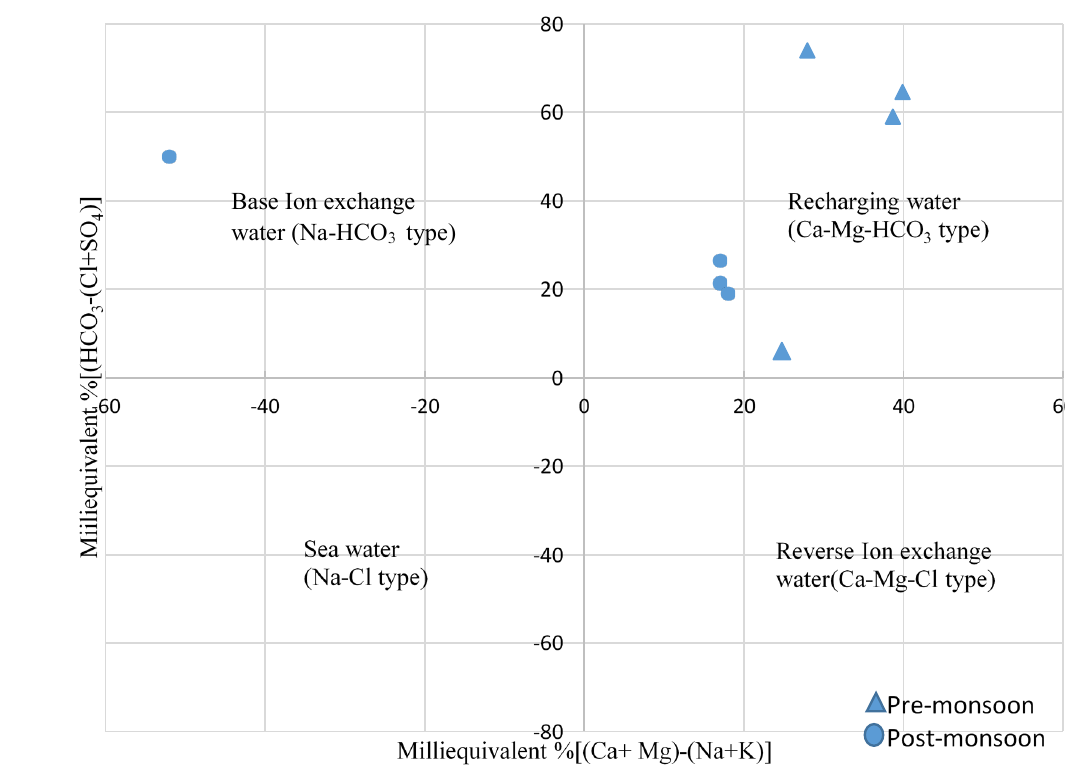
Figure 7. Chadha’s plot to reveal the driving geochemical process in the study area Fig. 7. Fig. 7. Chadha’s plot to reveal the driving geochemical process in the study area Chadha’s plot to reveal the driving geochemical process in the study area